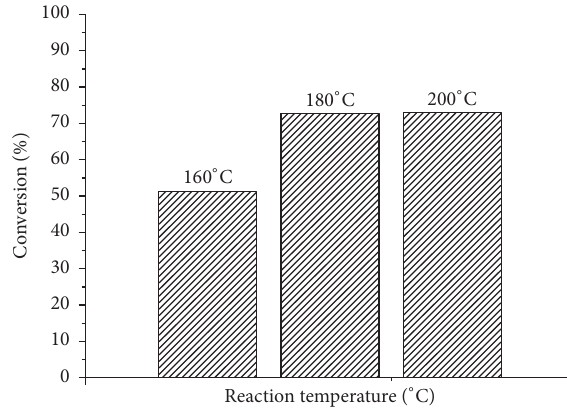
Figure 11: The influence of reaction temperature on esterification reaction.